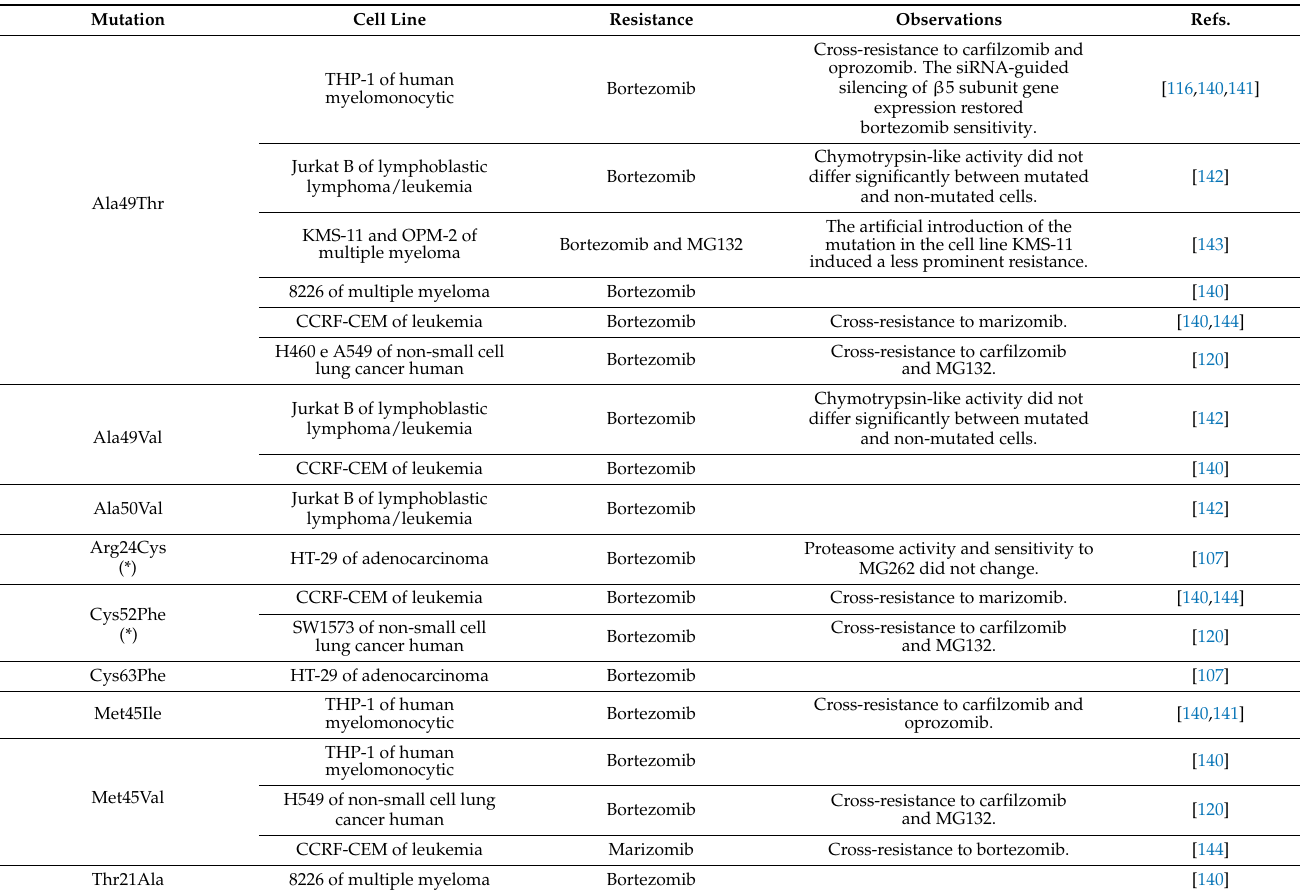
Table 2. Examples of mutations in the gene encoding the β 5 subunit of 20S CP, in cell lines resistant to 20S CP inhibitors. (*single nucleotide